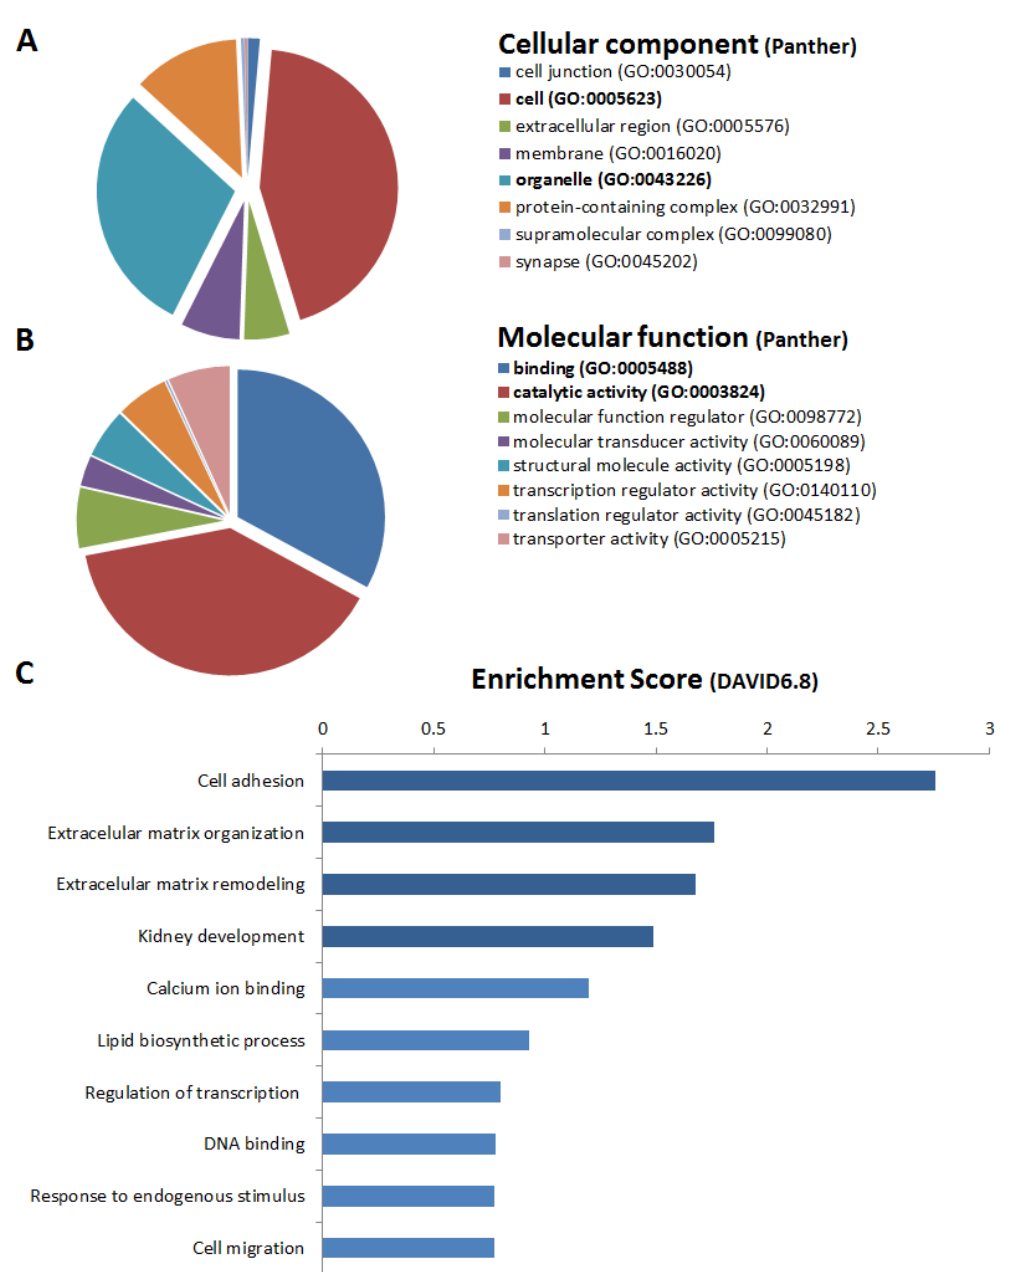
Figure 4. Genes upregulated in renal artery stenosis (RAS)-scattered tubular-like cells (STCs). Protein Analysis Through Evolutionary Relationships (PANTHER) analysis of cellular component ( A ) and molecular function ( B ) of genes upregulated in RAS-STCs. ( C ) Database for Annotation, Visualization, and Integrated Discovery (DAVID) 6.8 functional annotation analysis of messenger RNAs upregulated in RAS-STCs.